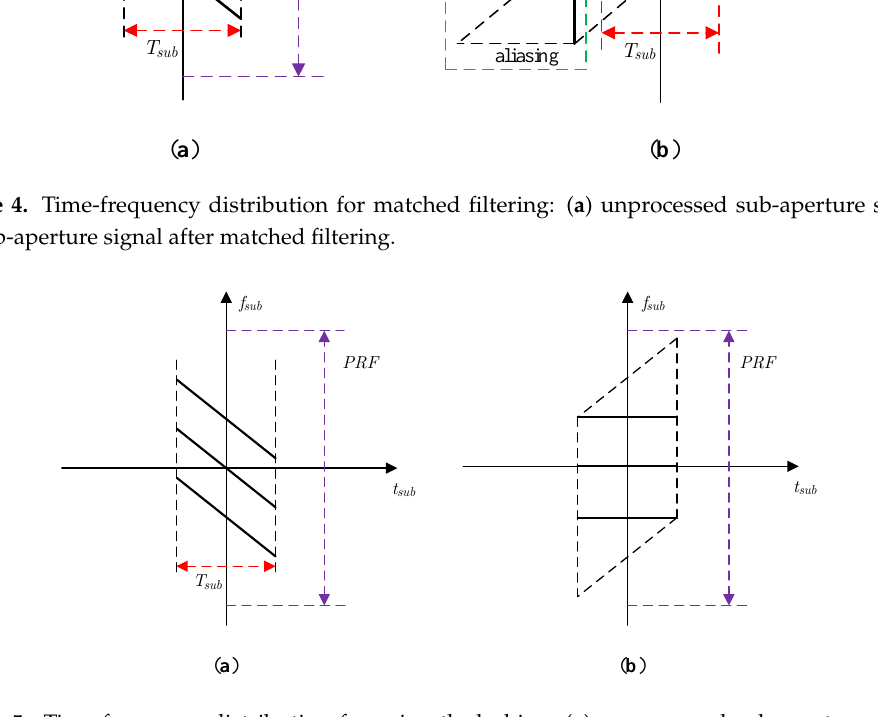
Figure 5. Time-frequency distribution for azimuth dechirp: ( a ) unprocessed sub-aperture signal; ( b ) sub-aperture signal after azimuth